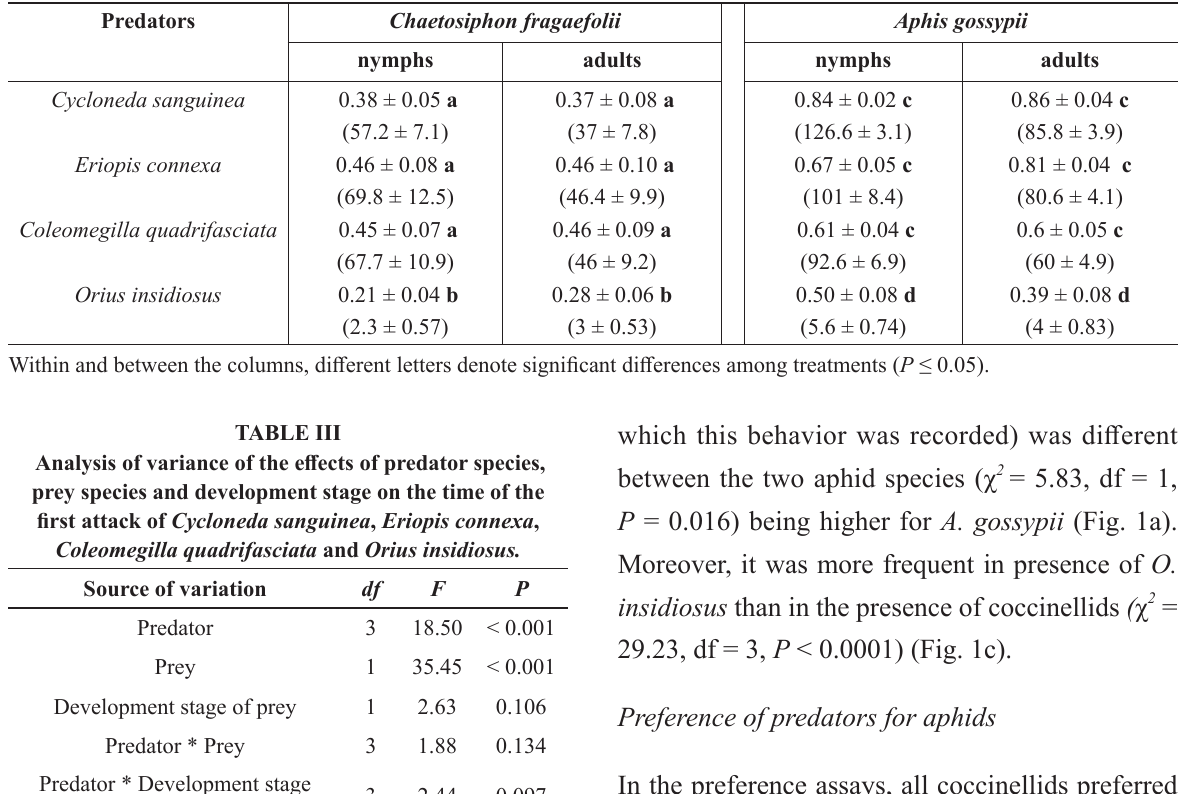
Predator * Prey * Development stage of